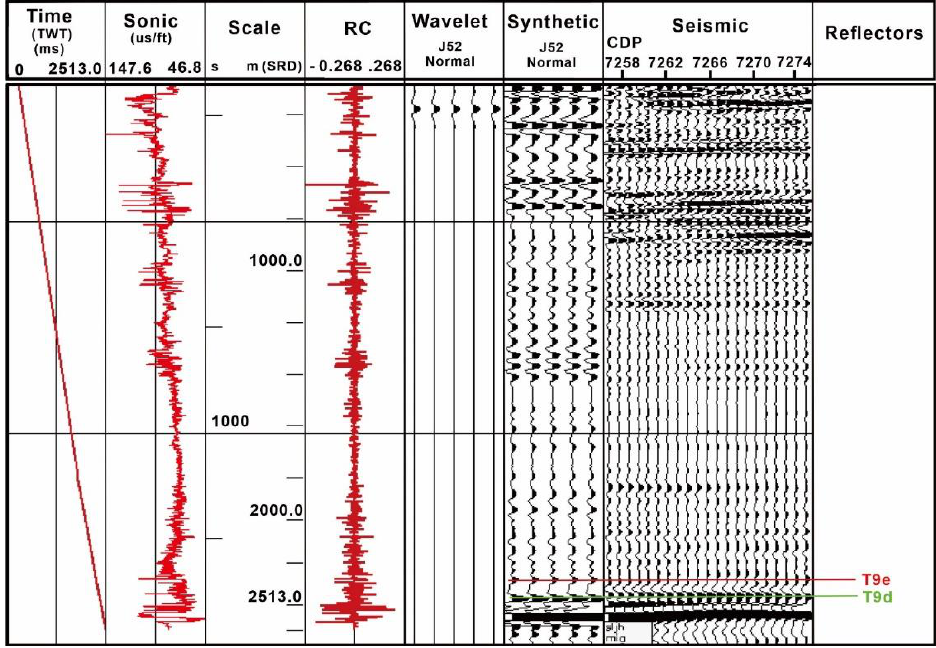
Figure 5. Synthetic seismogram of well J52 displaying the sonic log, synthetic and seismic traces. The interpreted horizons T9d and T9e are the targeted horizons that lie within the member-1 of the LSF.